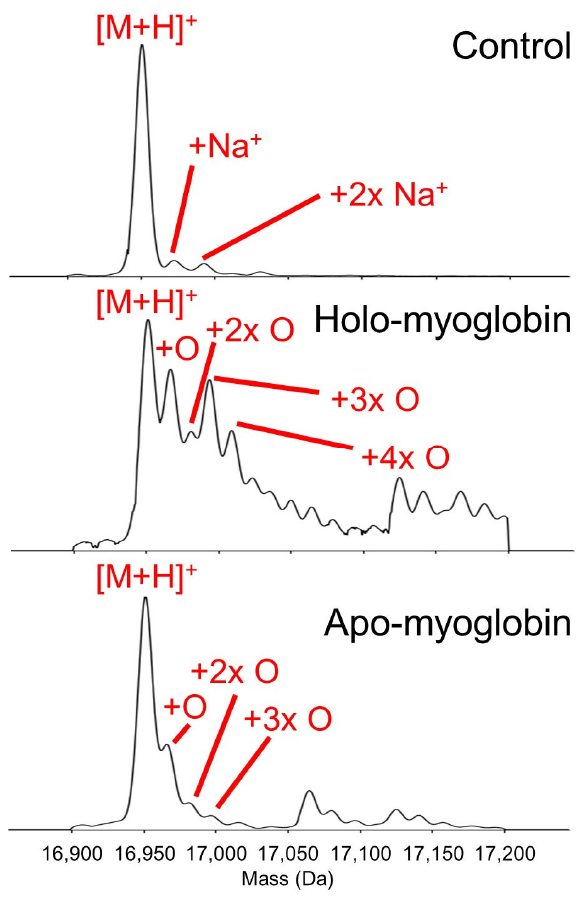
Figure 2. Deconvoluted mass spectra of apo ‐ myoglobin and holo ‐ myoglobin before (‘control’ experiment in the top panel) or after oxidative footprinting. Oxidative footprinting was carried out under native ‐ like conditions, but samples were chemically denatured prior to MS measurement, which is why the haem group is not retained in holo ‐ myoglobin. Only one spectrum is shown in the top panel as apo ‐ and holo ‐ myoglobin are identical after chemical denaturation.